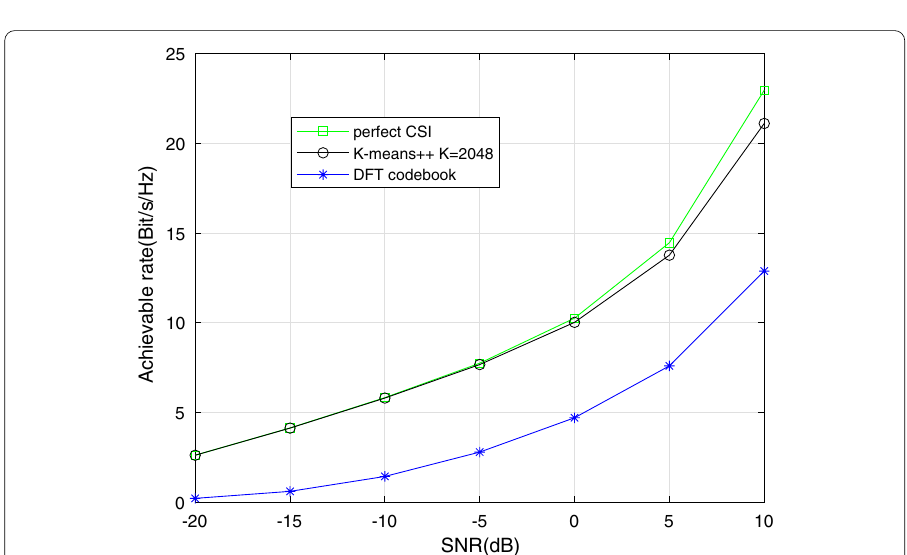
Fig. 5 Achievable rate performance of proposed codebook and DFT